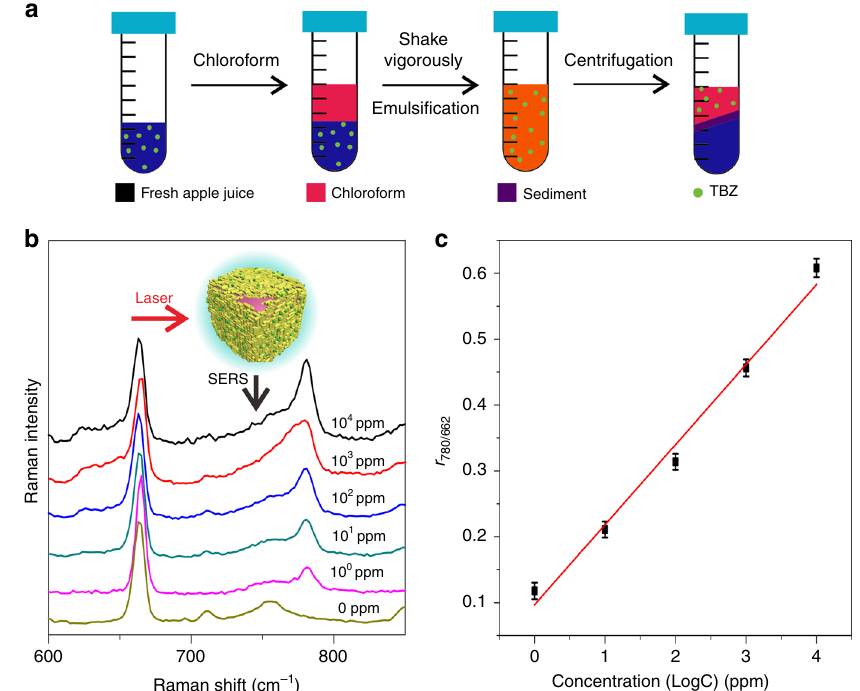
Fig. 9 Quantitative SERS analysis of TBZ in fresh juice. a Schematic for separating and concentrating of TBZ from fresh apple juice. b SERS spectra of TBZ with concentrations of 10 0 , 10 1 , 10 2 , 10 3 , and 10 4 ppm, respectively. c A linear plot of r 780/662 against logarithmic concentration of TBZ. The error bars represent the statistical RSD and were calculated from triplicate SERS experiments